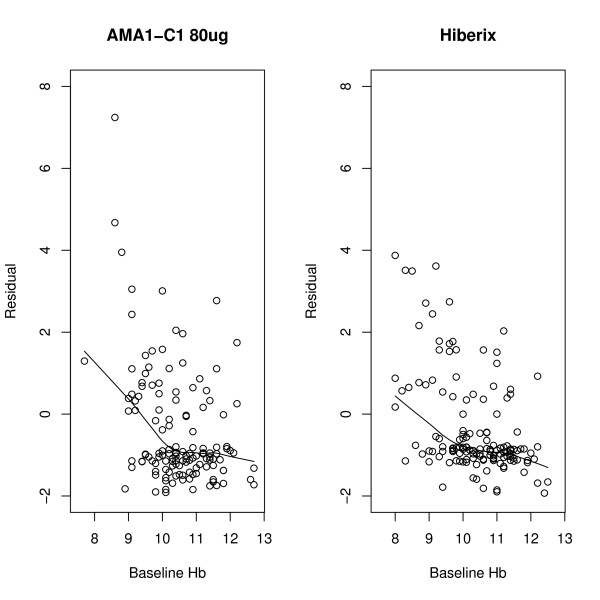
Plot of Residual from Poisson Regression. Lines are lowess smooths and motivate the functional form of the effect of baseline Hgb on the incidence rate of Hb < 8.5.